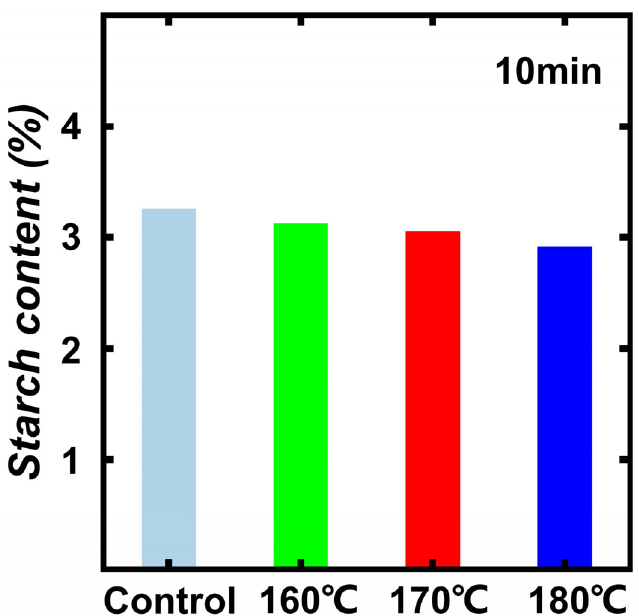
Figure 3. The starch content of different bamboo samples.